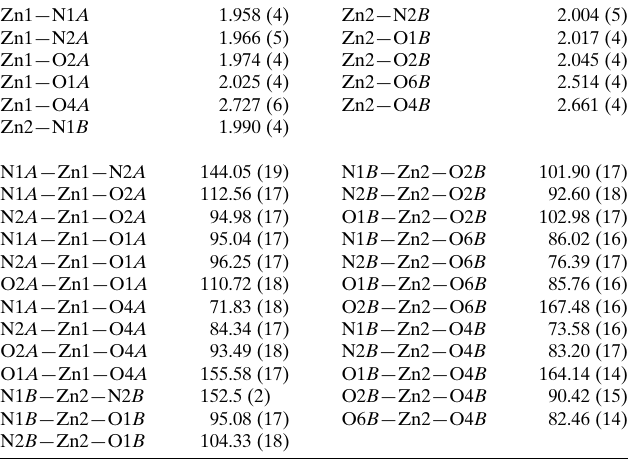
Table 1 Selected geometric parameters (A˚ , (cid:2) ).